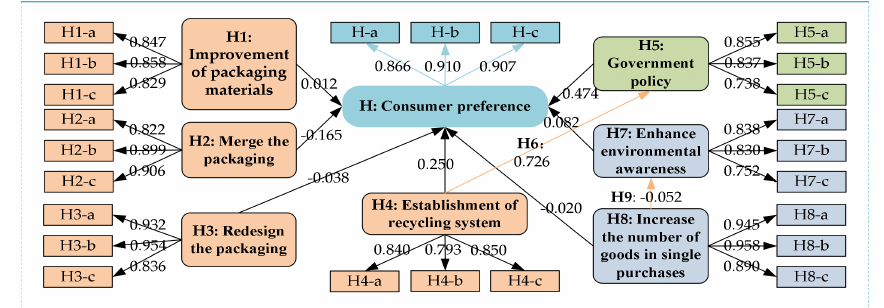
Figure A1. The model results, showing individual